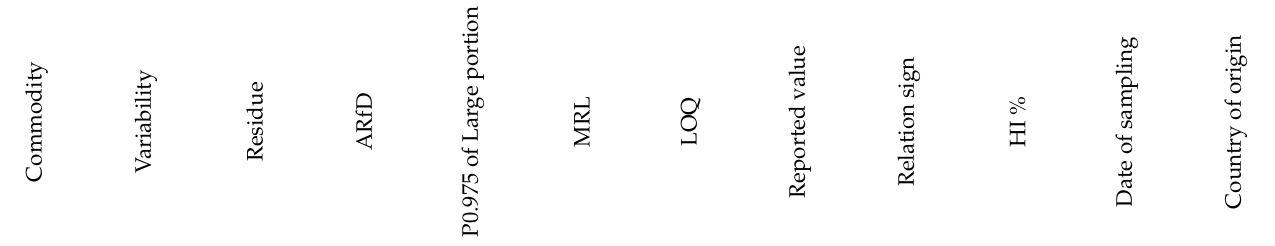
Table A7. Calculation of national short-term